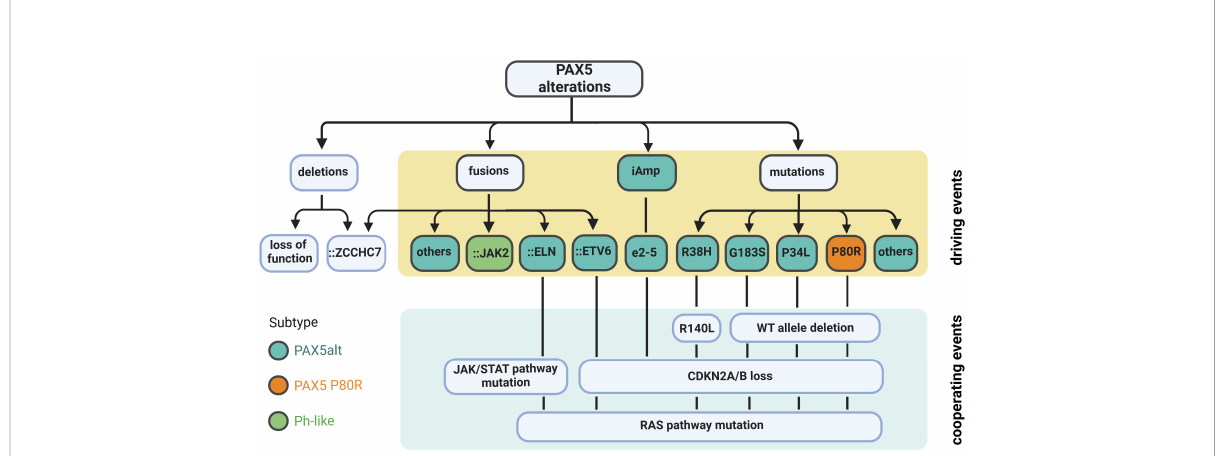
FIGURE 4 Summary of PAX5 alterations in B-ALL. Deletion is the most common type of PAX5 alteration in B-ALL, but generally considered as a secondary driver event. Focal deletion can lead to the concatenation of PAX5 to its adjacent gene ZCCHC7, a genetic lesion frequently observed in Ph-like and other B-ALL subtypes. PAX5 fusions, iAmp (most commonly targeting exon 2 to 5 (e2-5)), and point mutations are highly enriched in the PAX5alt subtype (16). PAX5 fusions and iAmp of e2-5 driven B-ALL harbor biallelic CDKN2A/B loss and RAS or JAK/STAT pathway mutations (16, 55, 58). PAX5 :: JAK2 , a signature fusion of the Ph-like subtype, can act as a dual hit for B-ALL without cooperating lesions (63). PAX5 -mutation- driven cases normally have deletion of the remaining WT allele and total loss of CDKN2A/B . They also frequently acquire mutations in the